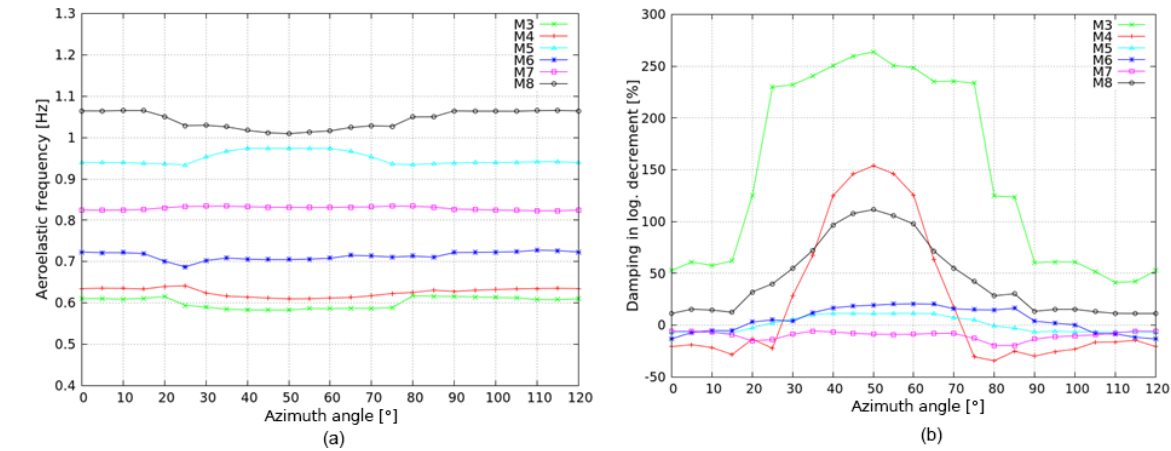
Figure 18. (a) Modal frequency and (b) modal damping of rotor modes versus azimuth angle at U = 42 . 5ms − 1 and yaw = 30 ◦ (steady-state